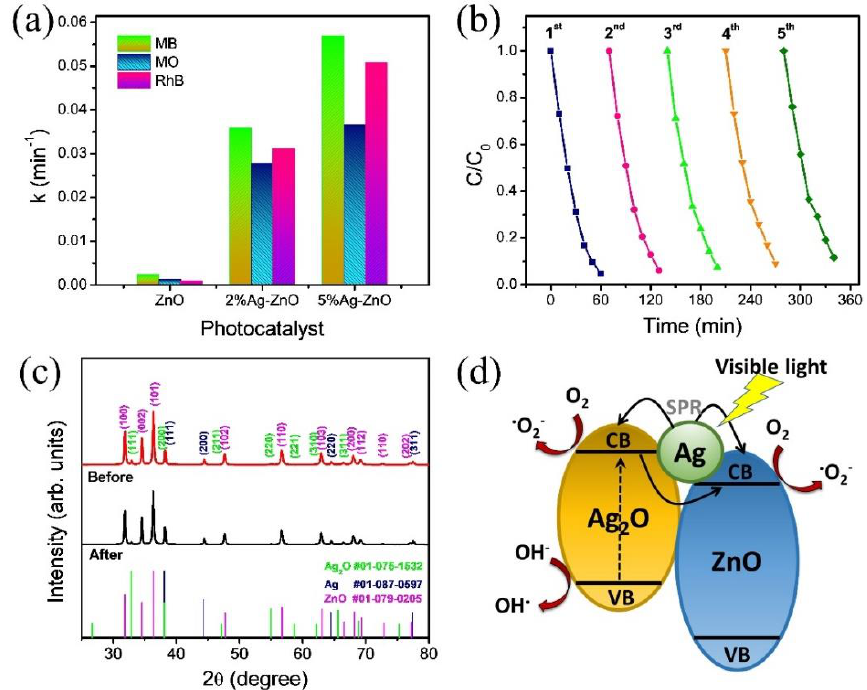
Figure 7. ( a ) Comparison of the pseudo-first-order kinetic rate constant of ZnO and Ag-ZnO, ( b ) cyclic stability test conducted for five repeated cycles of 5% Ag-ZnO sample for RhB; ( c ) X-ray diffraction pattern of 5% Ag-ZnO sample before and after the cyclic test for five cycles, and ( d ) schematic illustration of the possible mechanism for enhanced photocatalytic performance by heterojunction structure formation of Ag-Ag 2 O-ZnO. Table 2. Comparison between the photocatalytic performance of the prepared photocatalyst and some previous studies.